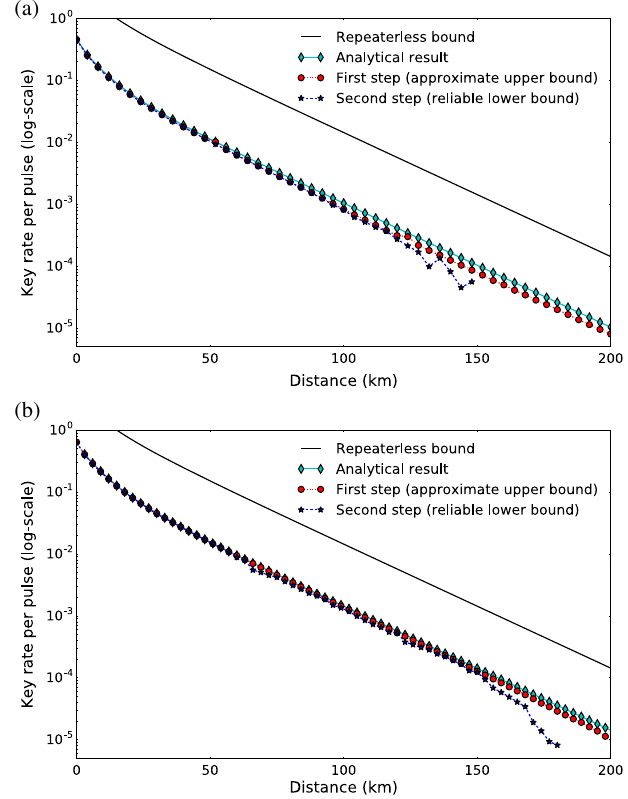
FIG. 2. Secure key rates versus the transmission distance for the pure-loss channel to demonstrate the numerical behavior of our two-step key rate calculation procedure and to compare with the analytical results (direct evaluation of Devetak-Winter formula) for both protocols. The transmittance is η ¼ 10 − 0 . 02 L for each distance L in kilometers, and the reconciliation efficiency is β ¼ 0 . 95 . The curve with circle markers is the approximate upper bound from the first step, and the curve with star markers is the reliable lower bound obtained from the second step. The curve with square markers is the analytical results presented in Appendix C. The solid line with no markers is the repeaterless secret key capacity bound [44,45]. (a) The key rate for protocol 1 (homodyne detection). The coherent state amplitude α is opti- mized via a coarse-grained search in the interval [0.36, 0.6]. (b) The key rate for protocol 2 (heterodyne detection). α is optimized via a coarse-grained search in the interval [0.6,